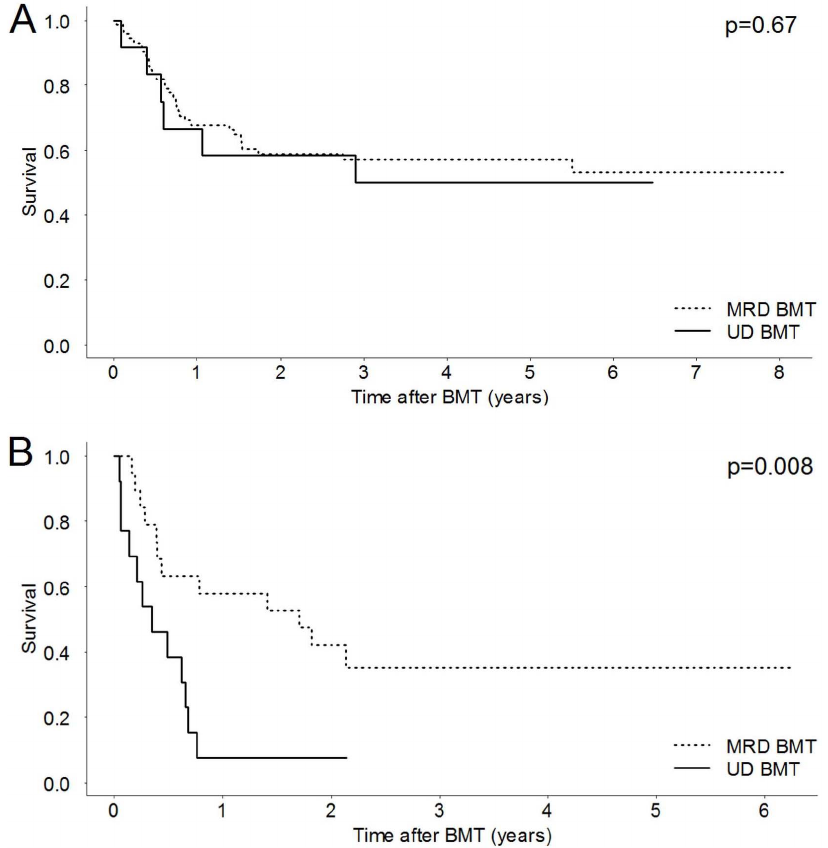
Figure 4. Kaplan-Meier curves for matched related donor (MRD) and unrelated donor (UD) bone marrow transplantation (BMT). (A) Overall survival in patients with non-advanced disease at the time of BMT. (B) Overall survival in patients with advanced disease at the time of BMT.